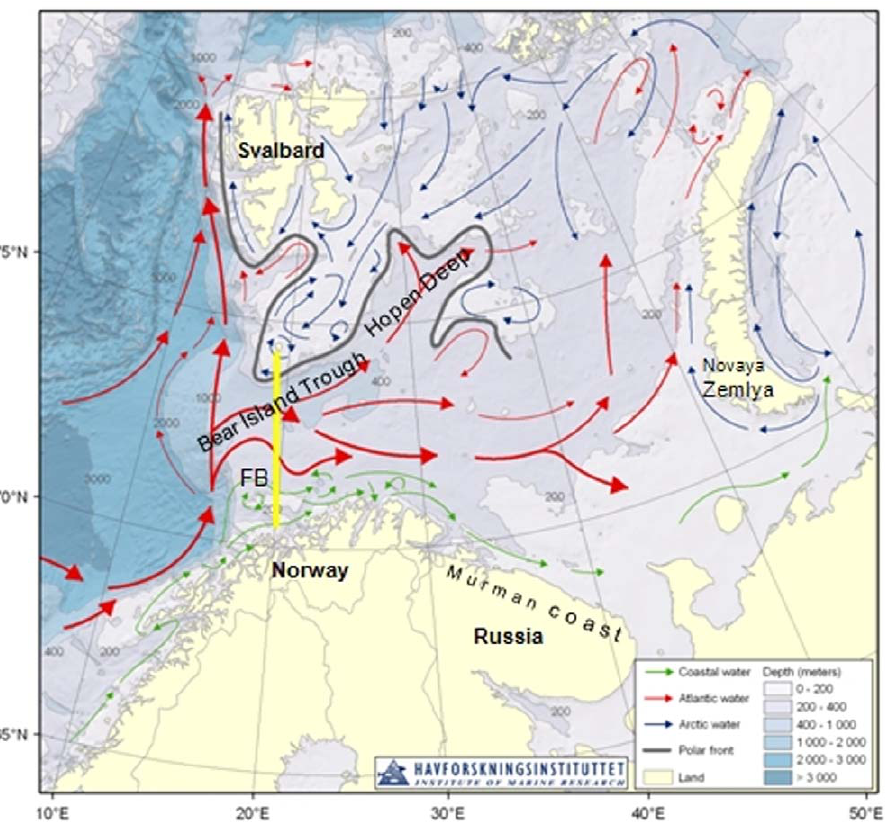
Figure 1. Map of the Barents Sea ( www.imr.no ), showing oceanographic and topographic features. The Fugløya-Bear Island (FB) section is shown by yellow